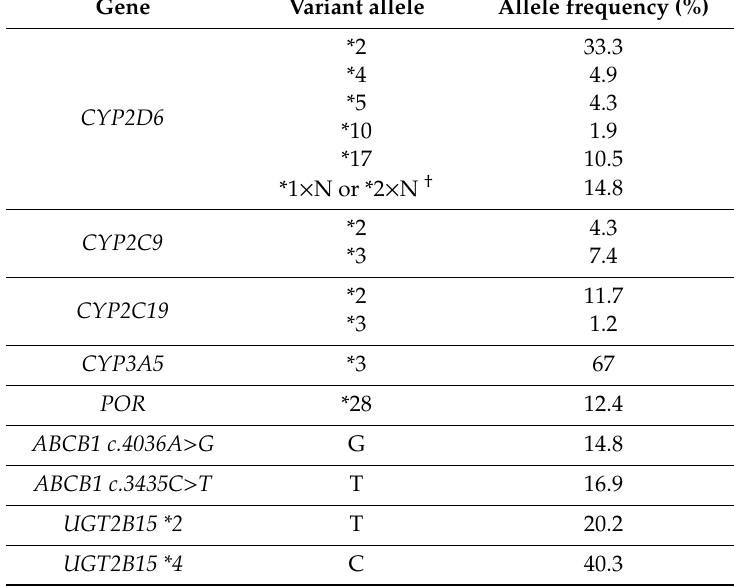
Table 2. The genotype and allele frequency distribution of tamoxifen metabolizing enzymes’ and transporter genes.